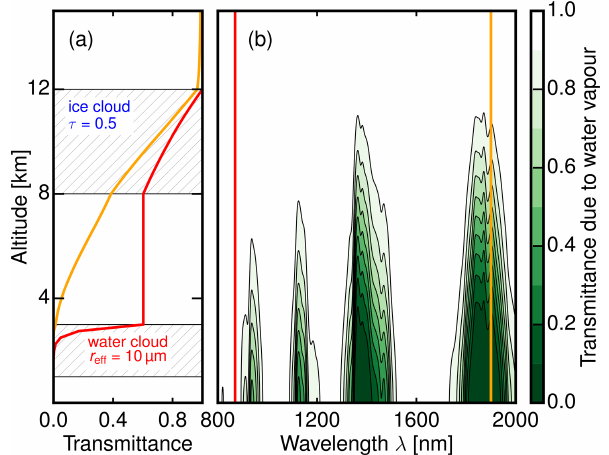
Figure 4. (a) Atmospheric transmittance of a water cloud and over- lying ice cloud layer at 870nm (red line) and 1 . 9µm (orange line). (b) The spectral transmittance of atmospheric water vapor acting as a vertical weighting